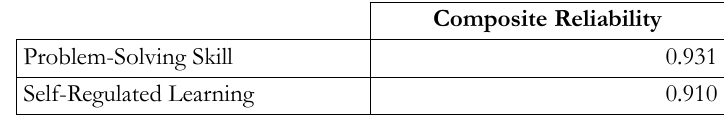
Table 3. Reflective measurement model assessment for the new model